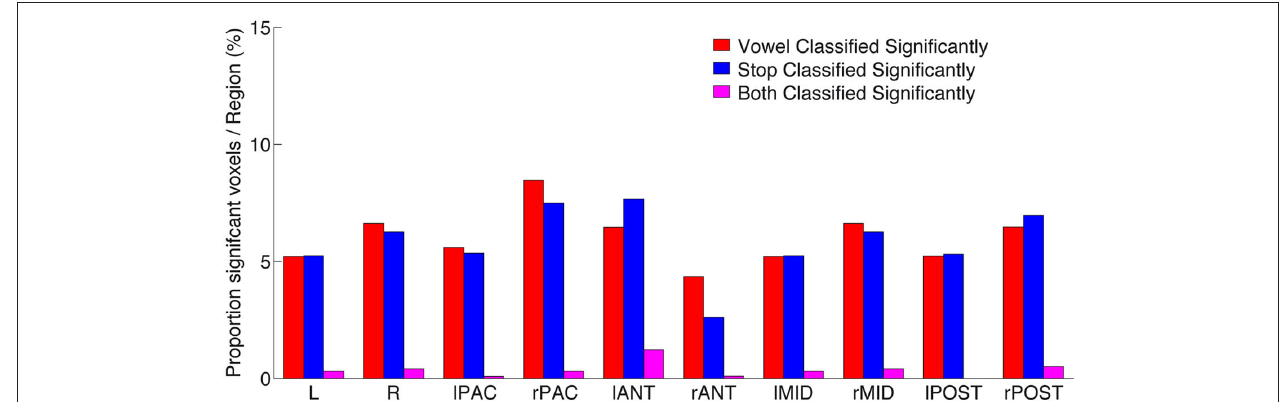
FIguRe 6 | Proportion of significantly above-chance voxels per region, for vowel (red) classification, stop (blue) classification, as well as voxels (and their immediate neighbors; see Materials and Methods) that